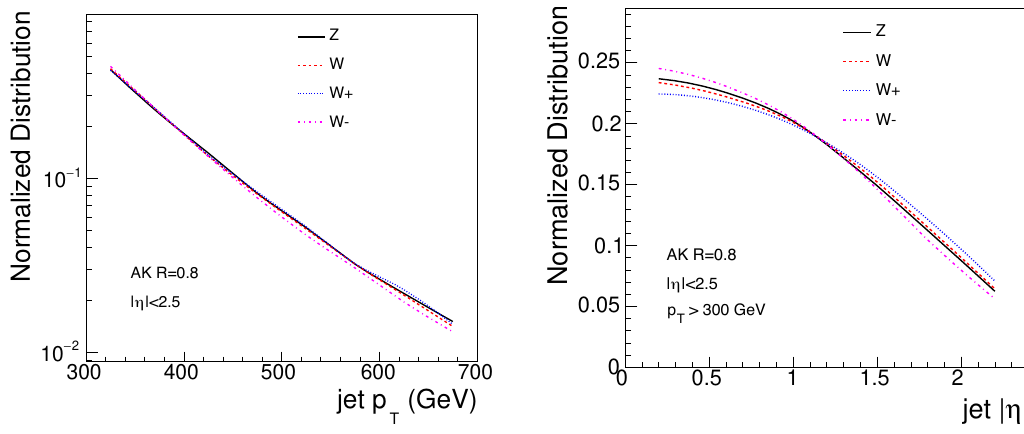
Figure 6 . Transverse momentum p T and j (cid:17) j of the leading jet with p T > 300 GeV in particle level simulation of W + jets, W + + jets, W (cid:0) + jets and Z + jets.